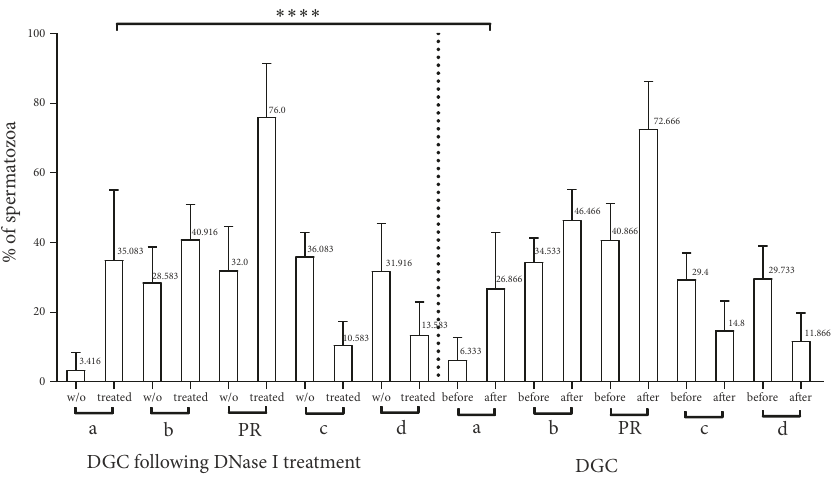
Figure 4: Comparison between DGC following DNase I treatment vs DGC alone in motility of hyperviscous semen. The combinatorial treatment had greater impact on spermatozoa movement than DGC alone. w/o: semen without treatment, treated: semen treated with DNase I, a: rapid progressive spermatozoa, b: slow progressive spermatozoa, c: non-progressive, d: immotile, and and PR: motility of (a+b).